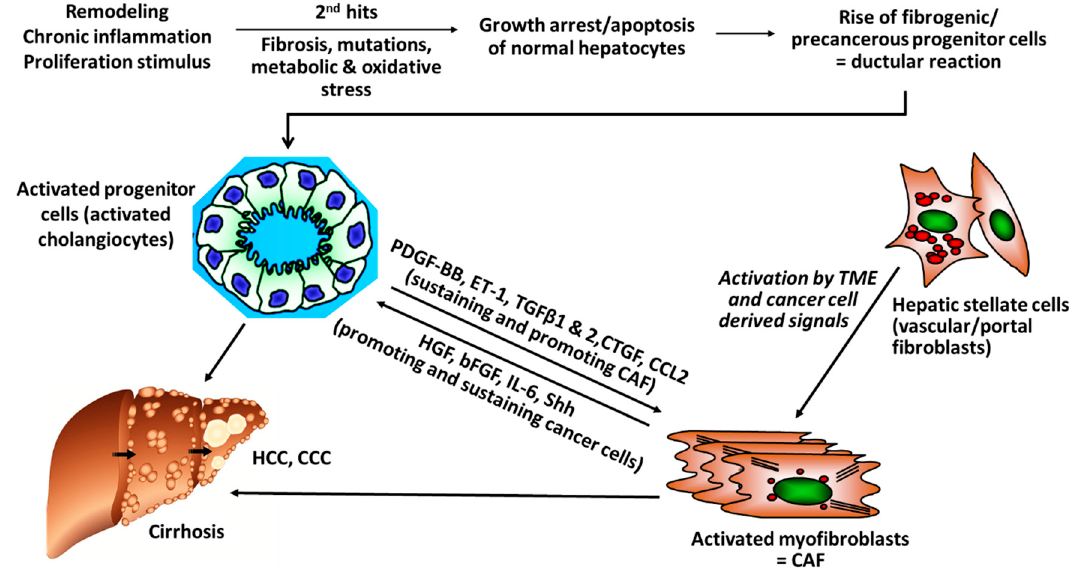
Figure 1. Versatile cross-talks of CAF with activated progenitor cells and HCC. Liver progenitor cells (activated cholangiocytes, oval cells) emerge once the liver is exposed to repetitive and multiple damage, including chronic inflammation of a “wound that does not heal.” The progenitor cells are more resistant to chronic stress and can di ff erentiate into healthy hepatocytes, when the injury subsides but also to fibrogenic and even cancerogenic epithelial progenitors. They engage in a bi-directional crosstalk with stromal cells that include inflammatory cells like TAM (M2-type macrophages) but also activated HSC / myofibroblasts that mutually sustain their growth and expansion, resulting in advanced fibrosis / cirrhosis and / or HCC and CCC. Apart from this pathway for fibrosis that is also prevalent in pancreatic ductal adenocarcinoma (PDAC) and other desmoplastic cancers, additional “second hits” like genetic alterations induced by hepatitis virus integration into the hepatocyte genome, other mutations or metabolic promoters, like in non-alcoholic steatohepatitis (NASH), further promote and sustain hepatic cancer (bFGF, basic fibroblast growth factor; CAF, Cancer-associated fibroblasts; CCL2, CC-Chemokin-Ligand-2 (CCL2); CTGF, connective tissue growth factor; ET-1, Endothelin-1; HGF, hepatocyte growth factor; IL-6 Interleukin 6; PDGF-BB / AB, platelet-derived growth factor BB / AB; Shh; hedgehog signaling pathway).